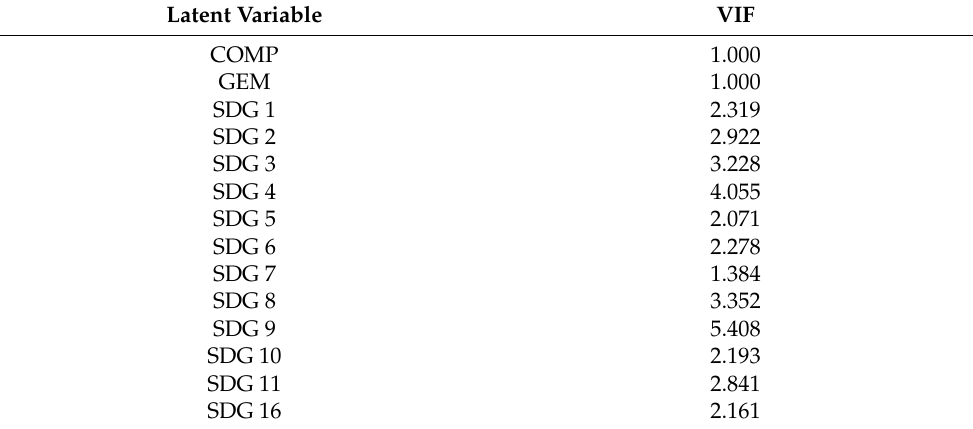
Table 3. Variance inflation factor.